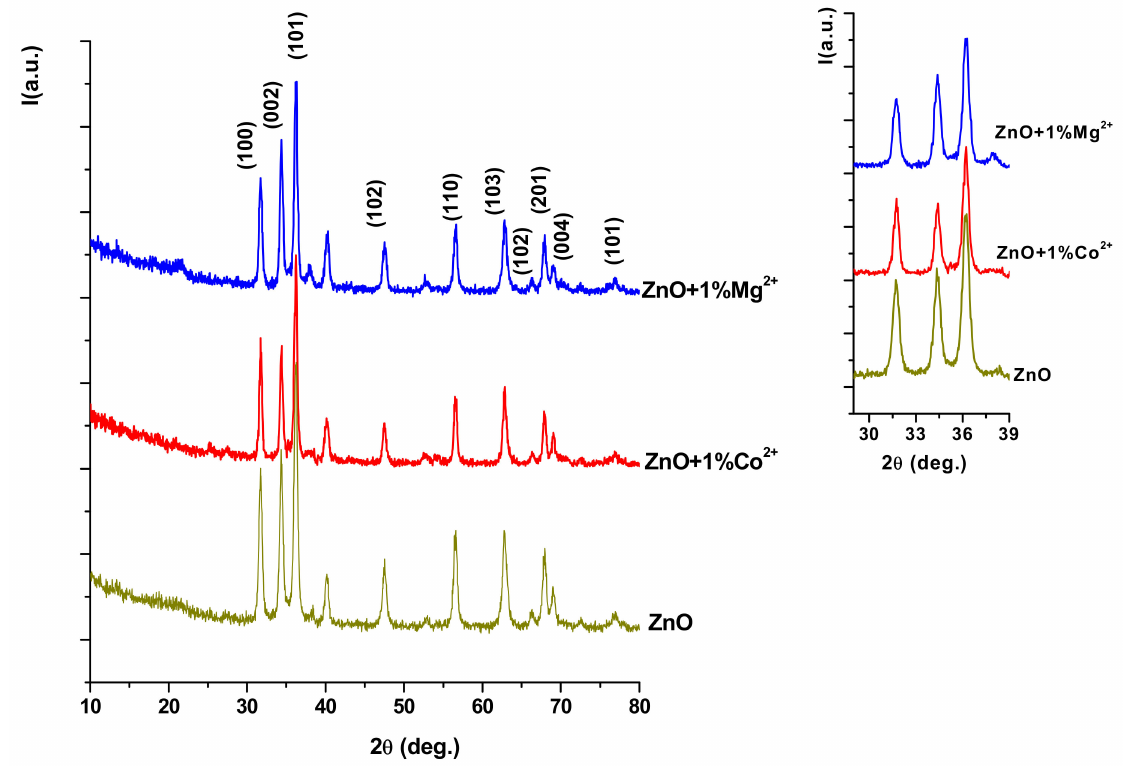
Figure 1. X-ray di ff raction (XRD) patterns for undoped and Co 2 + / Mg 2 + doped ZnO films coatings on grade TiAlV alloy thermally treated at 600 ◦ C for 2